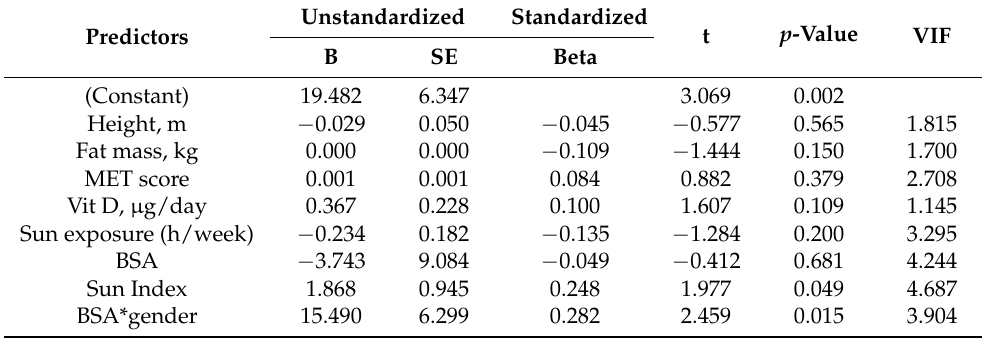
Table 3. Multiple linear regression analysis on predictors of serum 25(OH)D ( N = 243). Unstandardized Predictors